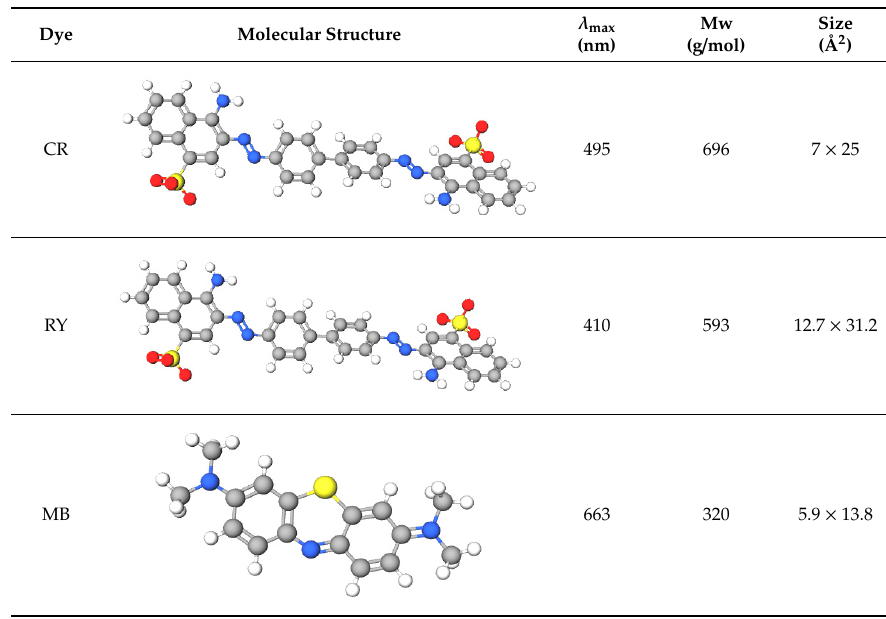
Figure 9. Effect of adsorbent type for MB decolorisation with ZSM ‐ 5 deSil ‐ deAl. Figure 9. E ff ect of adsorbent type for MB decolorisation with ZSM-5 deSil-deAl. Table 5. Characteristics of the studied Table 5. Characteristics of the studied dyes. Table 5. Characteristics of the studied dyes. Table 5. Characteristics of the studied dyes.